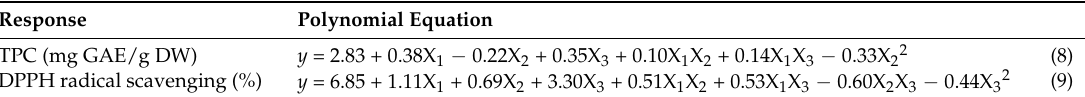
Table 5. Predictive model equations of the experimental response